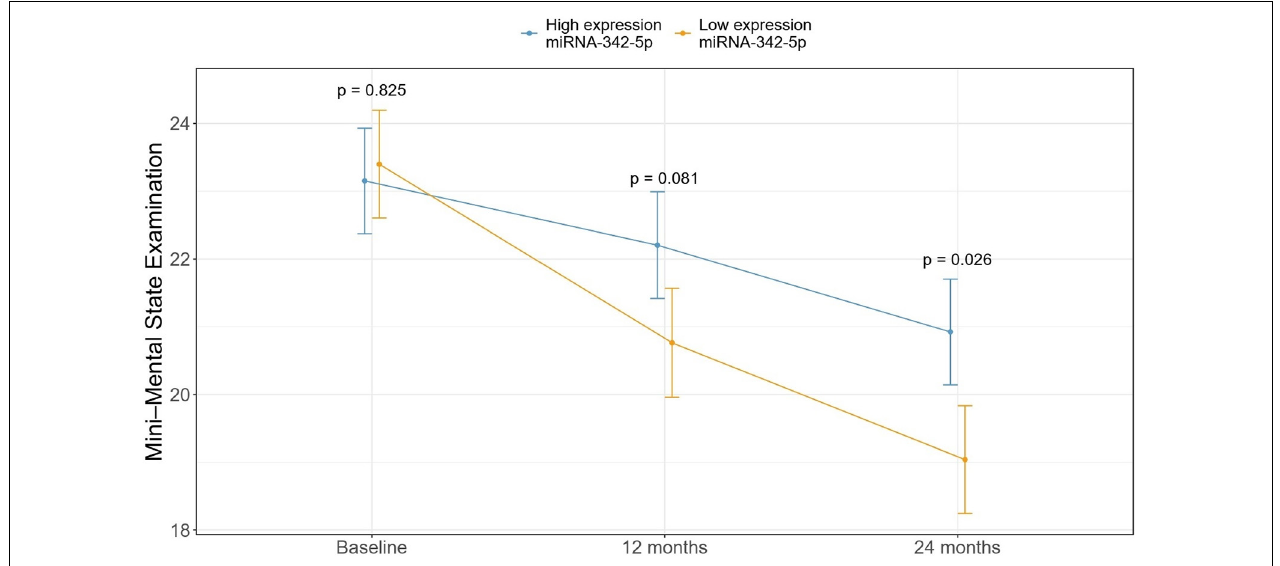
FIGURE 2 | The association between the mean MMSE score in patients with high and low expression of miR-342-5p at baseline and after 1 and 2 years of follow-up. Patients with higher expression of miR-342-5p at baseline showed a slower cognitive deterioration after 2 years of follow-up compared with patients with low expression of this